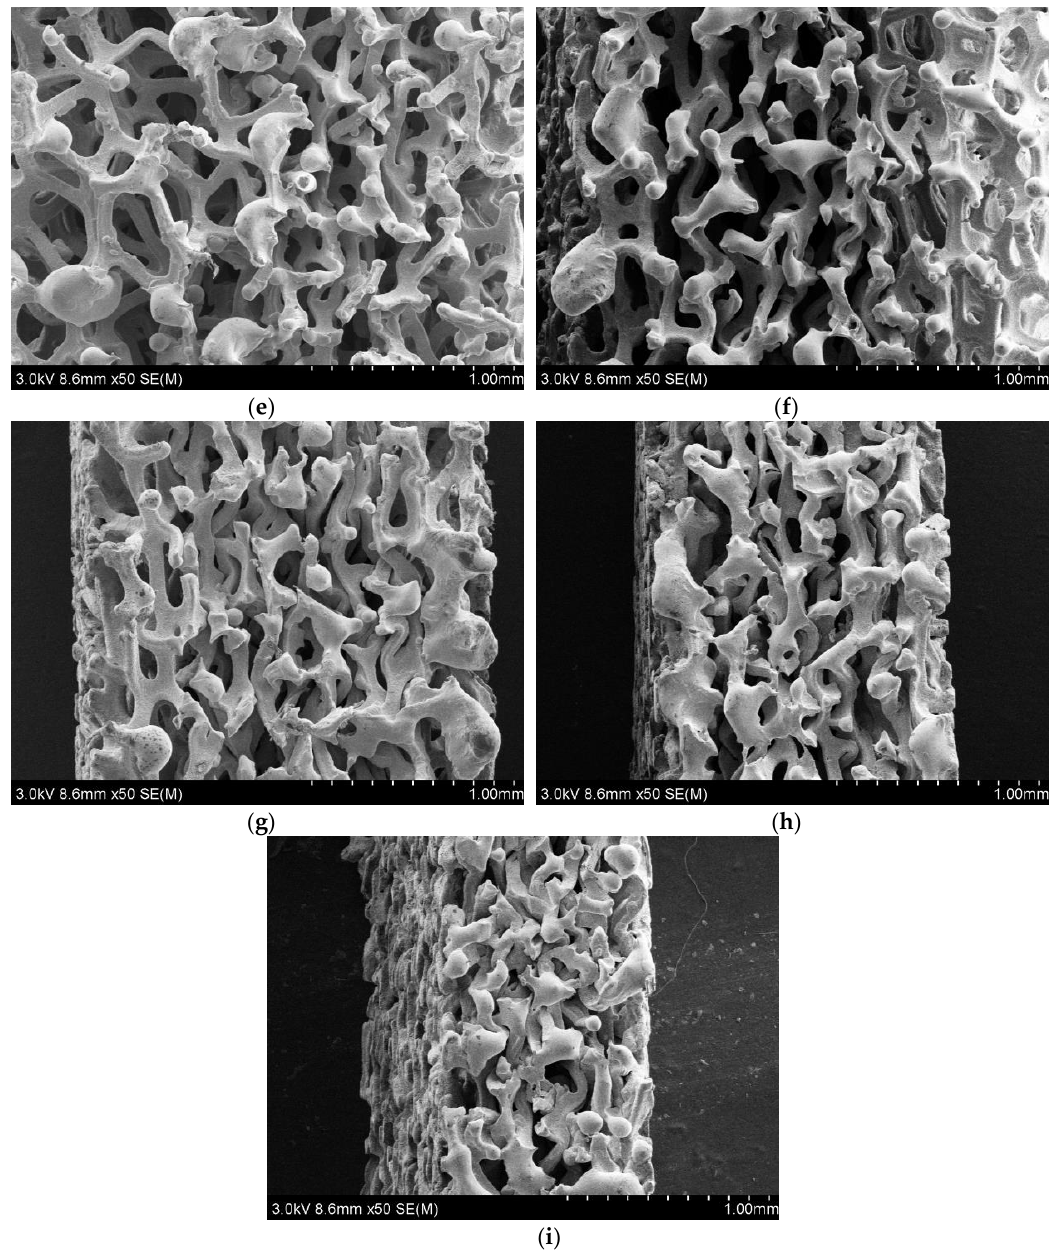
Figure 8. Section morphologies of the compressed Ni – Fe samples with different compression ratios.